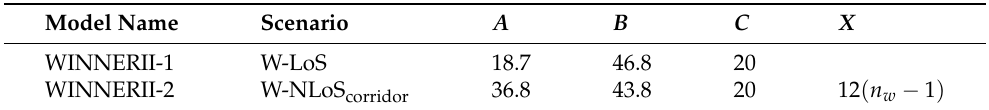
Table 2. Parameters for the WINNERII